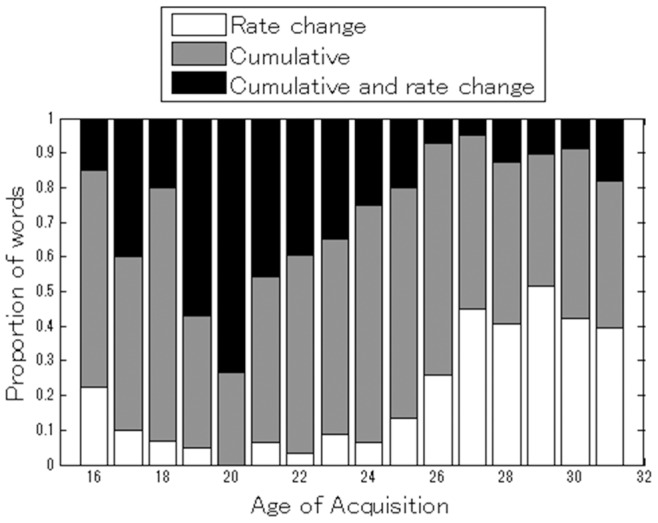
Proportion of words that best fit each model for different age groups.Ages are grouped based on median AoA from 16 to >30 (shown as 31).